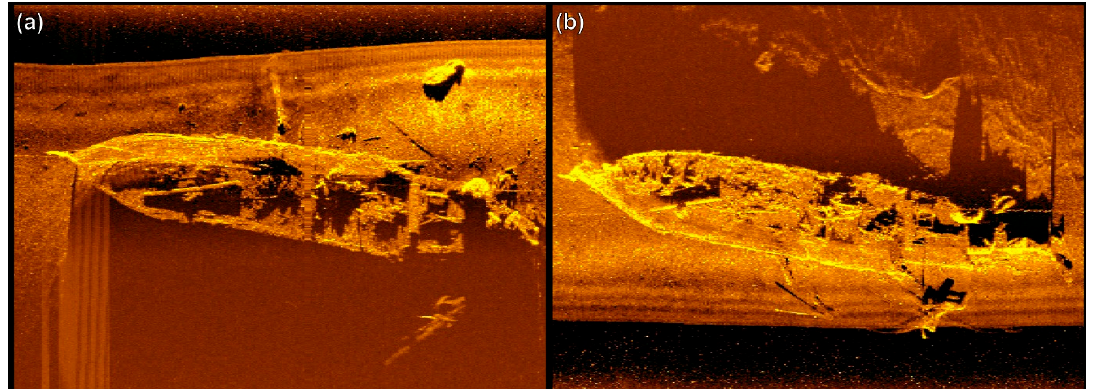
Figure 3. Autonomous underwater vehicle (AUV)-acquired sidescan sonar (SSS) images from alternate sides of the Figaro in Trygghamna. Panels ( a ) and ( b ) respectively show images from the starboard-side and port-side AUV passes of the wreck. The wreck measures approximately 50 m long, and 11 m wide. In total, 2:34 h of HD ROV-video of the wreck site were acquired. The di ff erent parts of the hull and a number of objects were inspected at close range for identification and to assess the